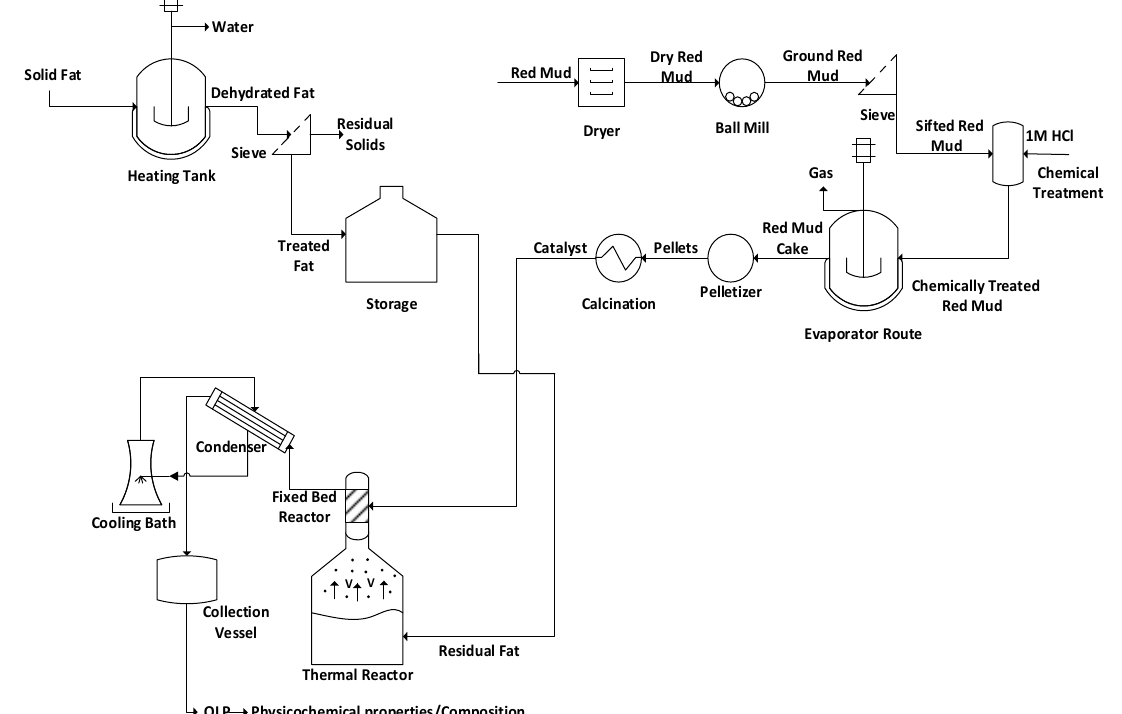
Figure 1. Process flowsheet by the production of hydrocarbon liquid mixtures by thermal cracking and thermal catalytic cracking of residual fat at 450 °C, 1.0 atm, 5.0, 7.5, and 10.0% (wt.) of red mud pellets activated with 1.0 M HCl, using a catalyst fixed bed reactor, in semi pilot scale.